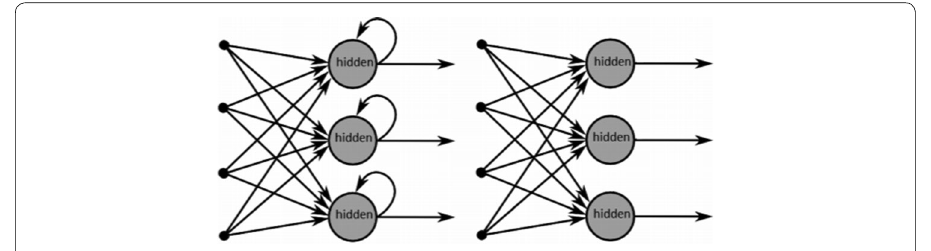
Fig. 1 RNN (left) vs. feedforward (right)